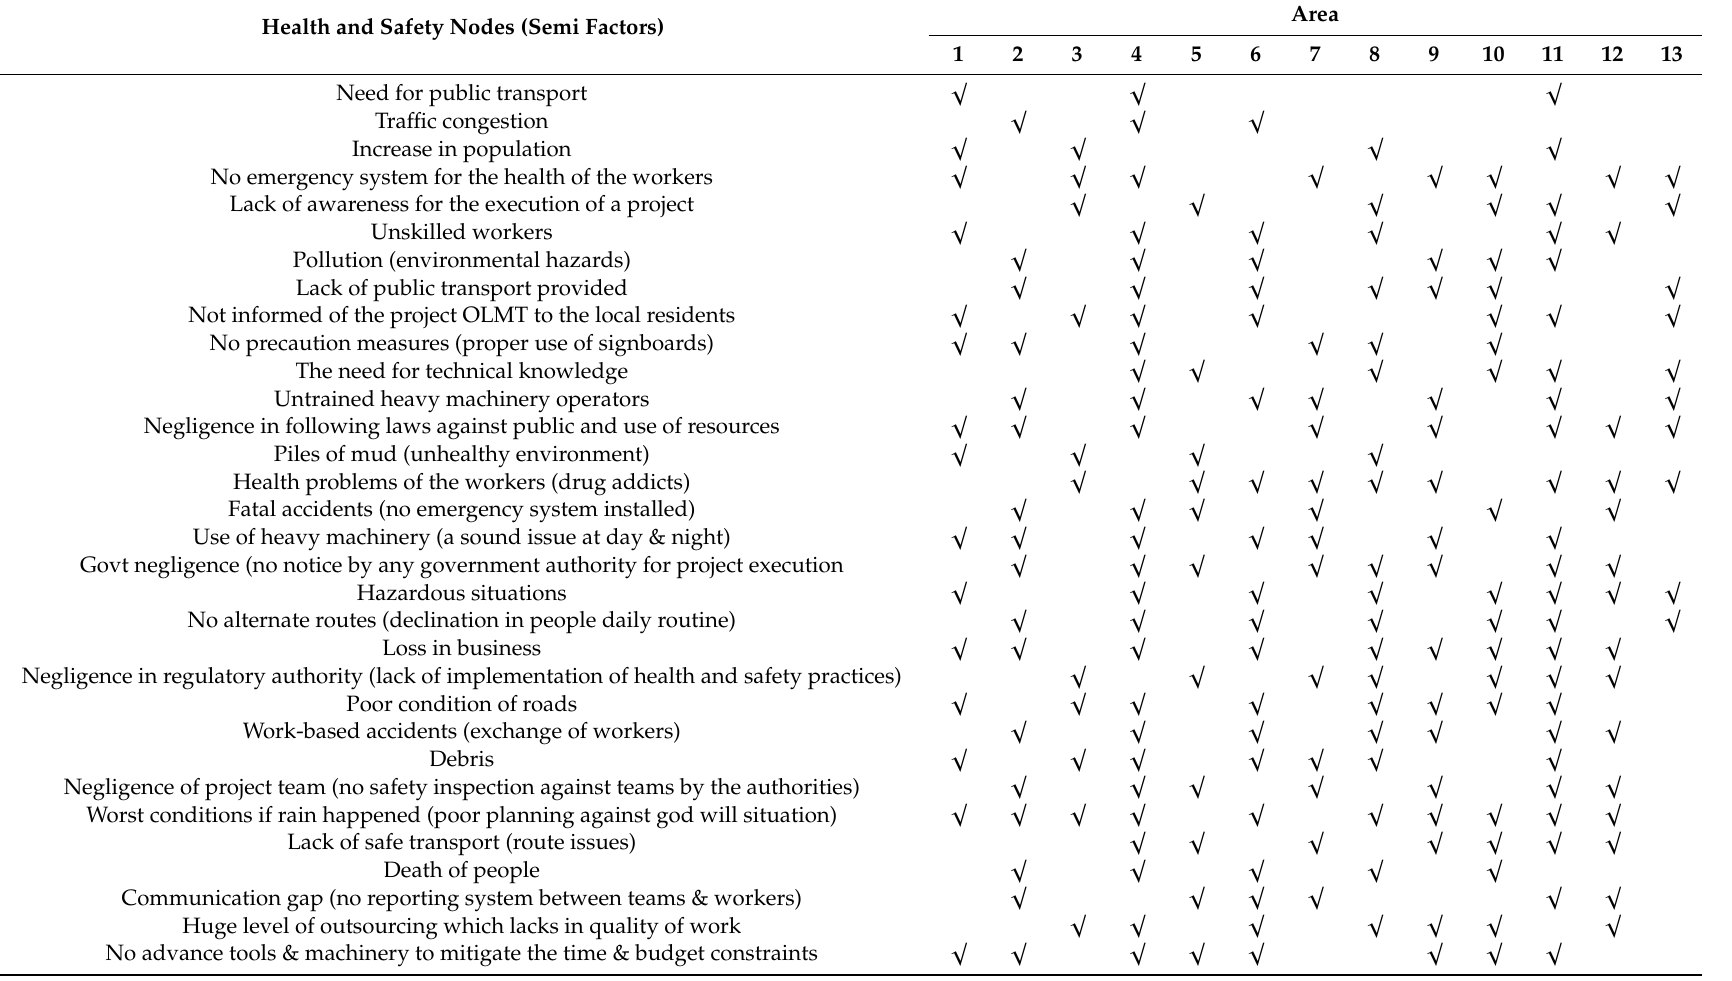
Table 3. Health and safety nodes (semi